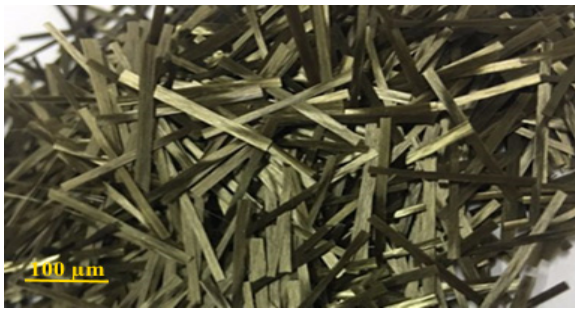
Figure 2. Chopped BF. Table 1. Physical properties and sieve analysis of LECA.